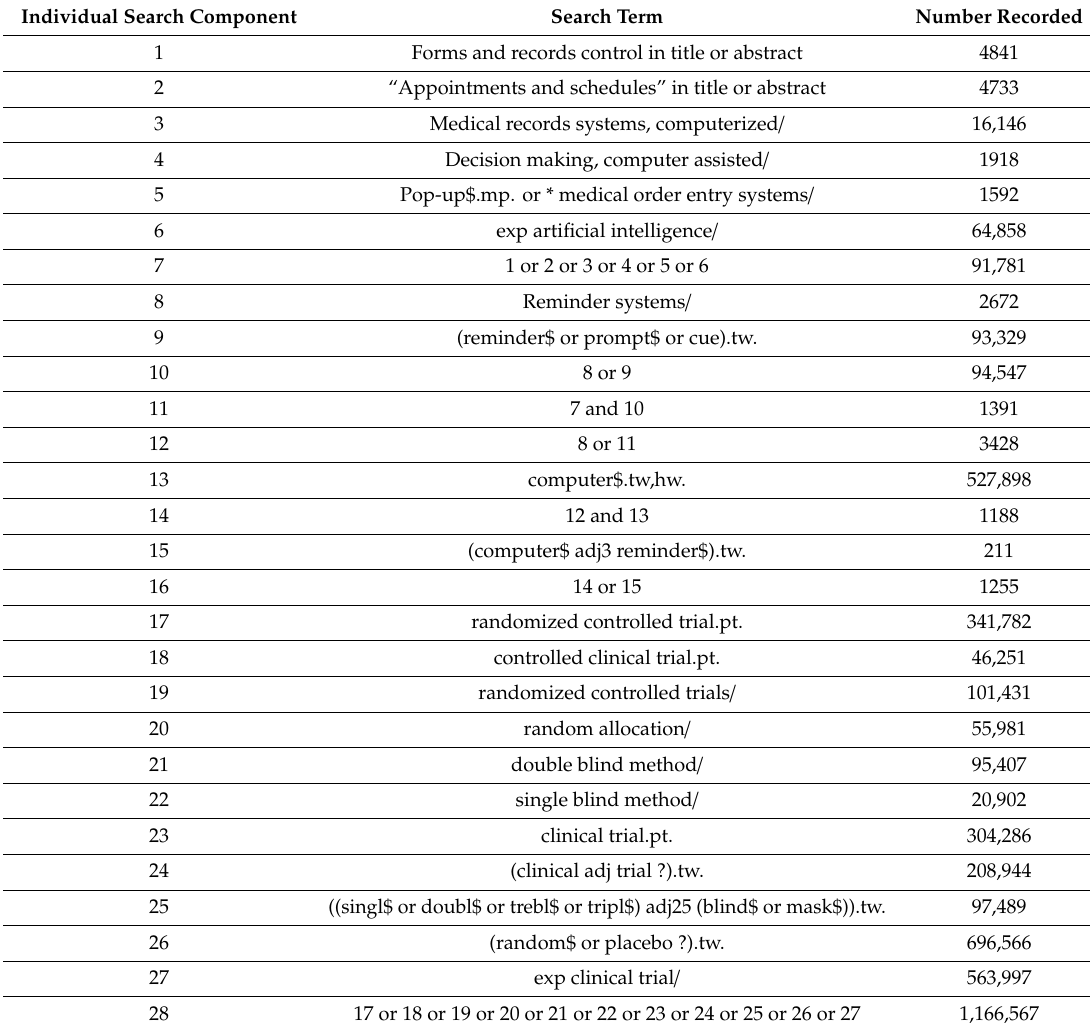
Table A2. Example search strategy (MEDLINE) for the rapid review of factors making alerts on clinical record computer systems more e ff